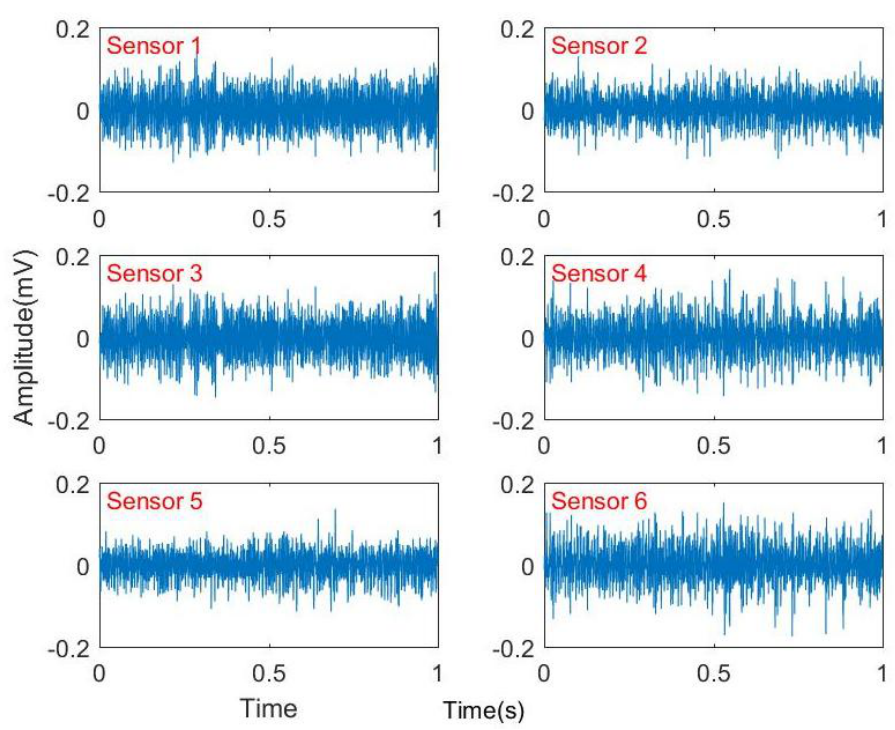
Figure 8. Waves of vibration signals under outer-race